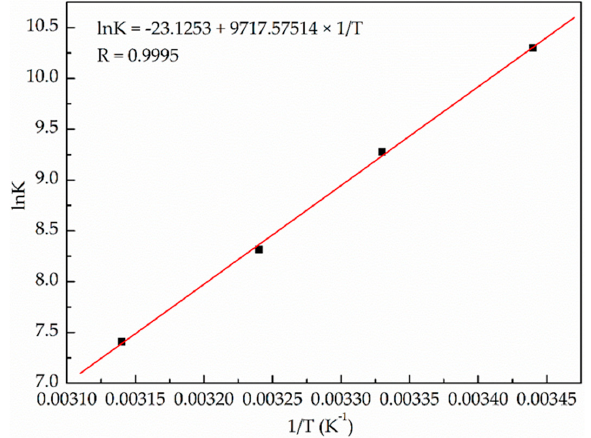
Figure 3. Van’t Hoff linear regression analysis for the interaction of 2-MT with